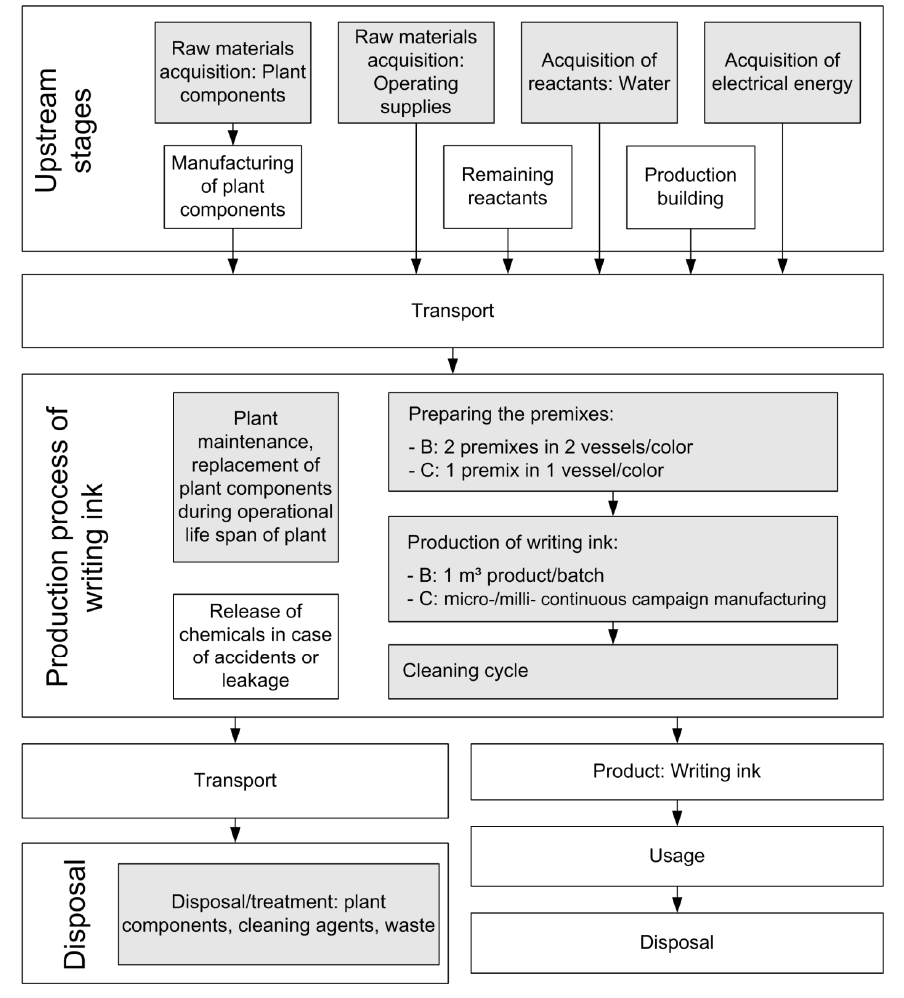
Figure 1. System boundaries for the ecological assessment of both process alternatives [23]. The included lifecycle stages and components are shaded in